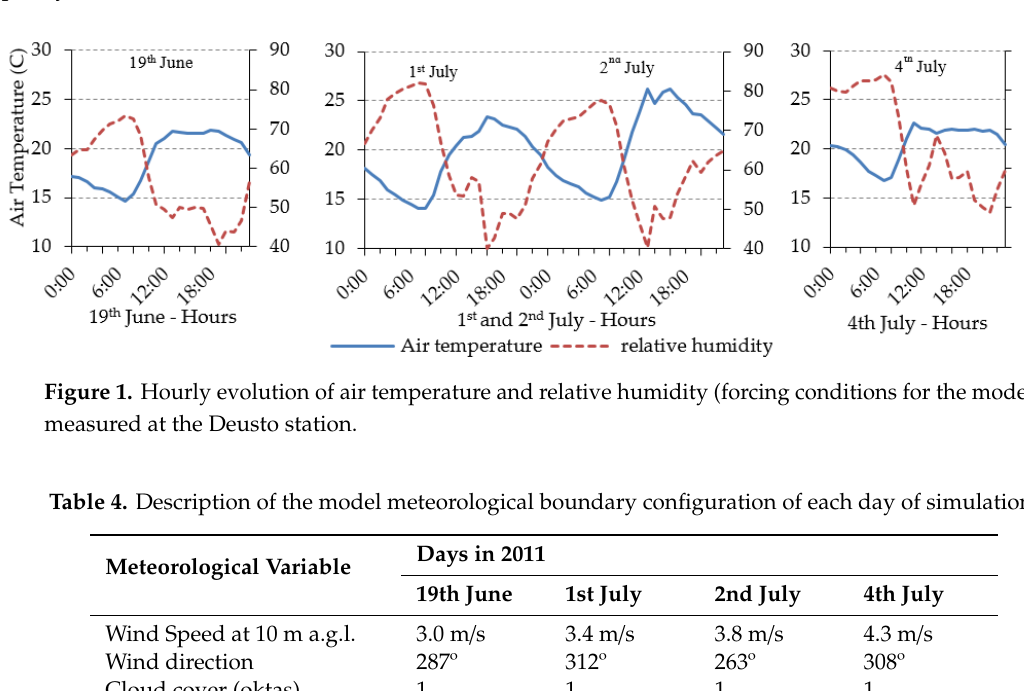
Table 4. Simulations were launched at 4:00 local time (i.e., UTC + 2), approximately 3 h before sunrise.